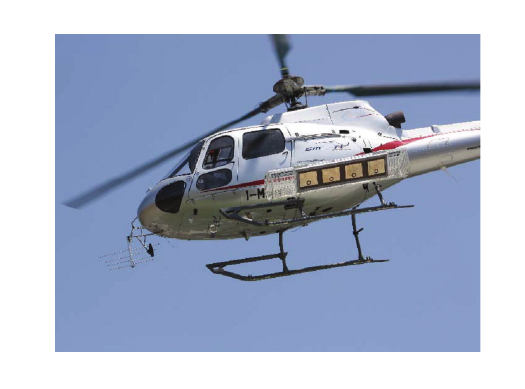
Figure 3: Sounder and imager antenna in flight configuration.